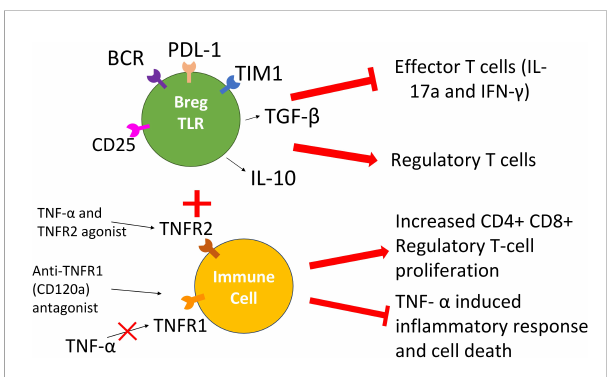
FIGURE 2 Scheme of the proposed combinatorial Breg-TLR/TNFR1/R2 therapy. The approach involves the combined administration of Bregs-TLR cells that induce suppressive Treg cells (suppression of anti-graft responses), a TNFR1 antagonistic antibody (reduction of in fl ammatory responses toward the transplant) and a TNFR2 agonistic drug (boost of tolerogenic